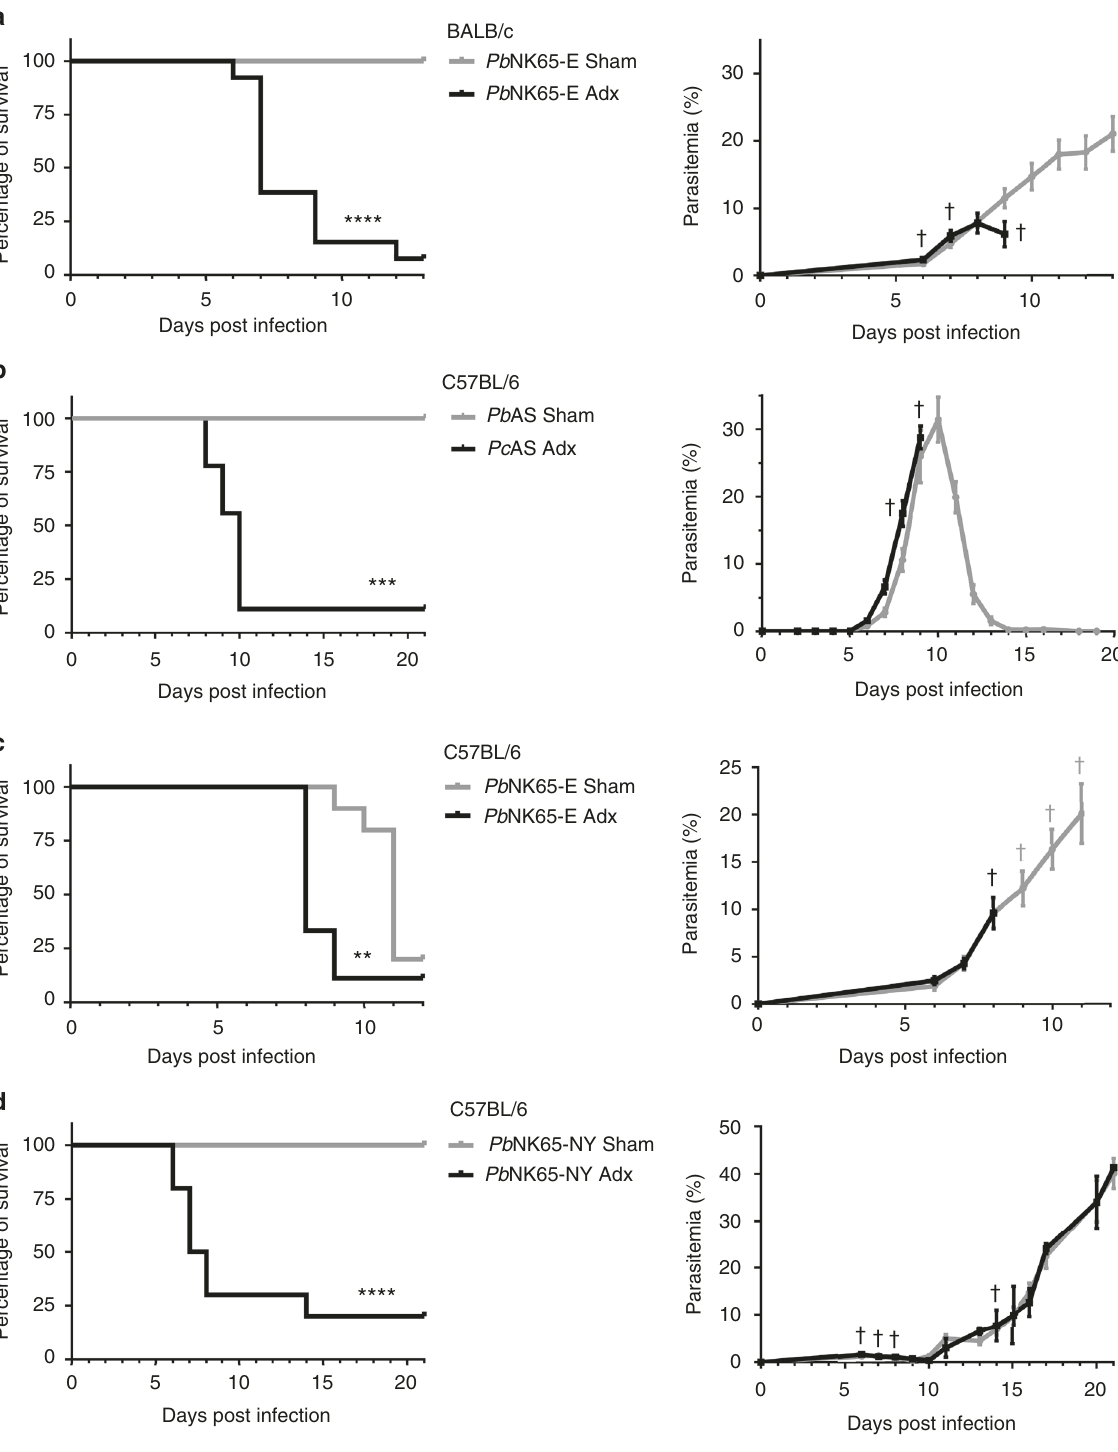
Fig. 1 Adrenalectomy reduces survival following infection, without affecting parasitemia. Sham-operated (Sham) and adrenalectomised (Adx) BALB/c mice ( a ) or C57BL/6 mice ( b – d ) were injected with Plasmodium berghei NK65 Edinburgh strain ( Pb NK65-E; a and c ), Plasmodium chabaudi AS ( Pc AS; b ) or Pb NK65 New York strain ( Pb NK65-NY; d ). Survival of Adx and Sham mice was monitored daily. In each experiment, non-infected Sham and Adx mice were included and these all survived the observation period (not shown). The peripheral parasitemia of infected mice was determined at the indicated time points and shown as means ± SEM. Graphs represent two or three separate experiments and the numbers of mice are as follows: a Sham, n = 14; Adx, n = 13; b Sham, n = 8; Adx, n = 9; c Sham, n = 10; Adx, n = 9; d Sham, n = 12; Adx, n = 10. No parasitemia of Adx mice is shown where two or fewer mice remained alive: after day 9 ( a , b ) or day 8 ( c ). Daggers ( † ) indicate when at least one mouse died or was euthanized when it reached the humane endpoints. Asterisks indicate signi fi cance levels by Log-rank test. ** p < 0.01, *** p < 0.001, **** p <